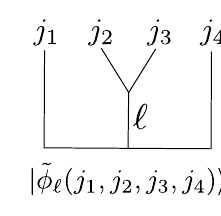
Figure 8 . Two different bases for the SU(2) k 4-point conformal